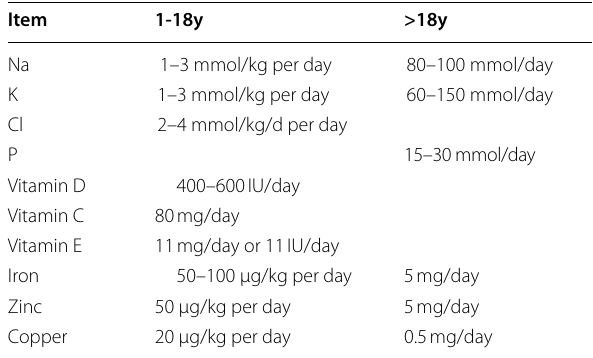
Table 4 Protein requirement in different patients Patient